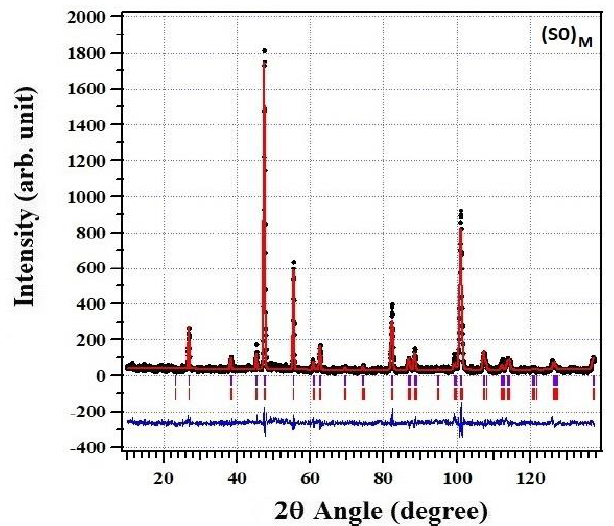
Figure 7. Neutron diffraction patterns of LaMnO3 (S0), the Rietveld analysis results based on the nuclear- and magnetic phase using basis functions of IRreps (1), with  2 =